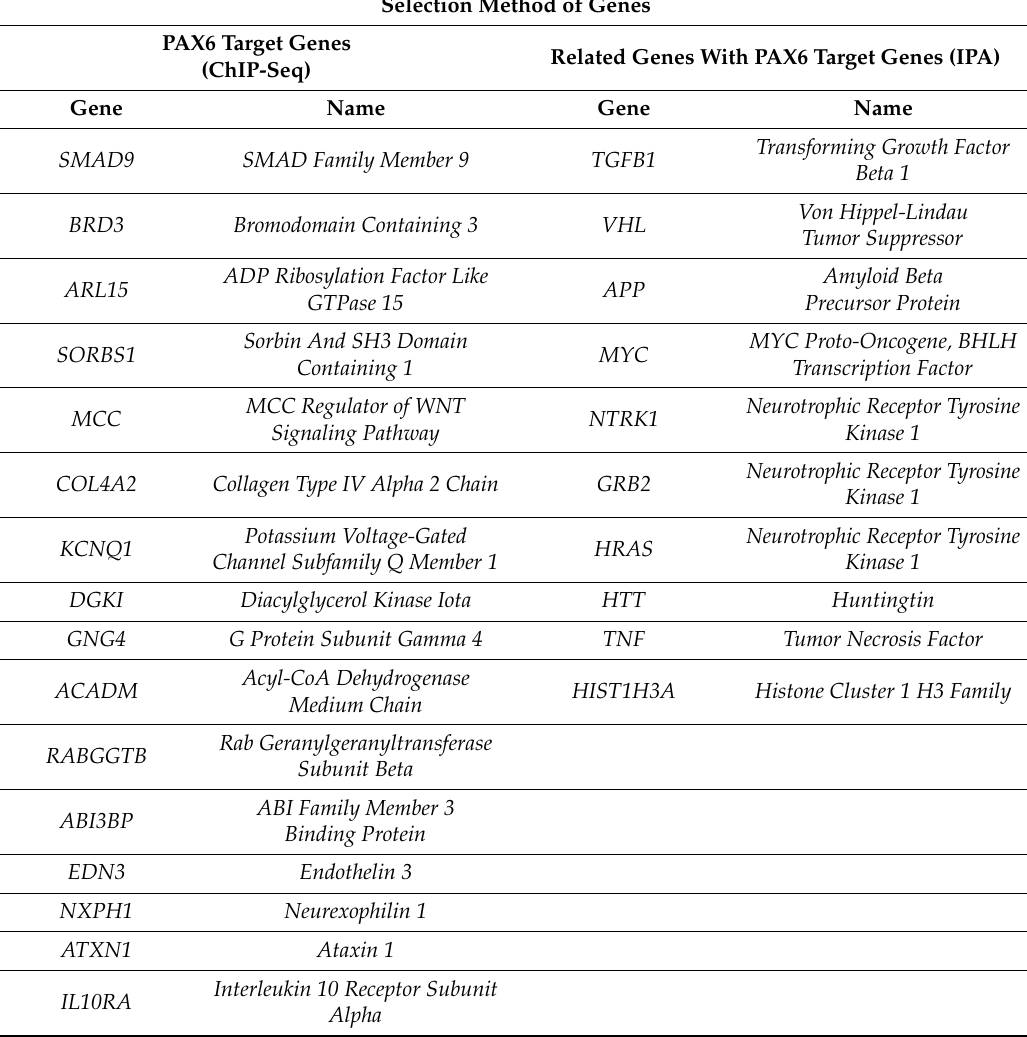
Table 3. Human Selected Genes to Assess Their Expression Study in Human